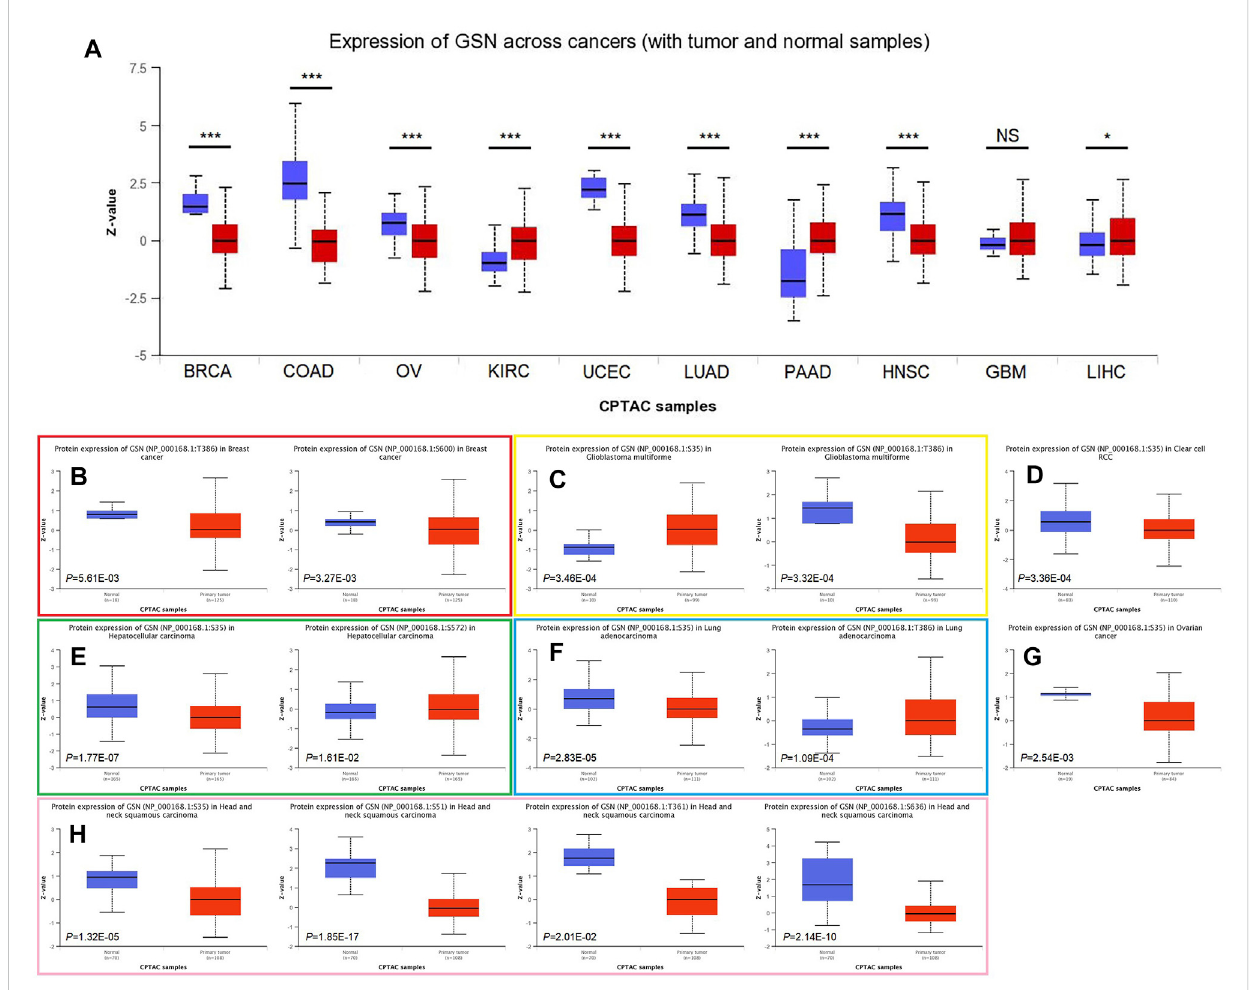
FIGURE 7 Differences in GSN protein content and phosphorylation levels in pan-carcinoma. (A) Differences in GSN protein content in pan-carcinoma, including BRCA, COAD, OV, KIRC, UCEC, LUAD, PAAD, HNSC, GBM, and LIHC. Phosphorylation levels of GSN proteins varied in BRCA (B) , GBM (C) , KIRC (D) , LIHC (E) , LUAD (F) , OV (G) , and HNSC (H) . (* p < 0.05, *** p < 0.001, NS: p >